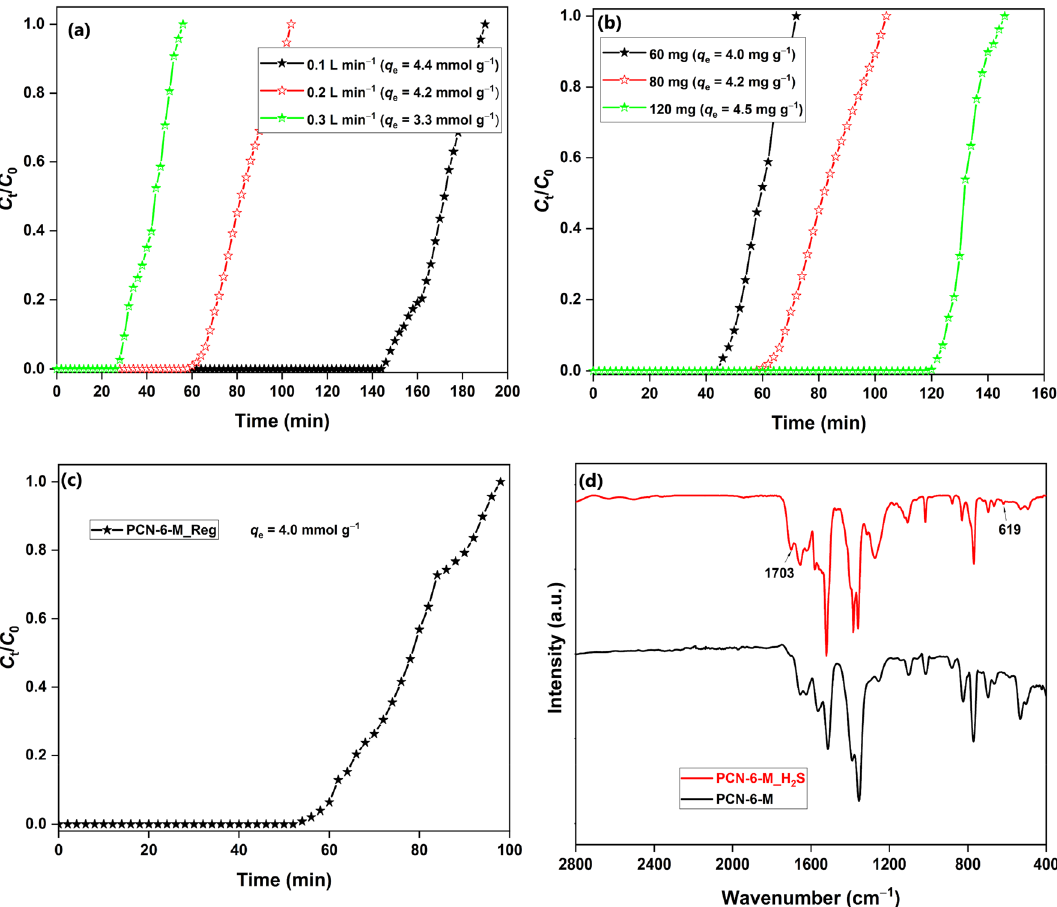
Figure 4. Effect of ( a ) flowrate; ( b ) MOF mass on H 2 S adsorption capacity of PCN-6-M; ( c ) H 2 S breakthrough curve of regenerated PCN-6-M; ( d ) FTIR spectra of fresh and H 2 S-adsorbed PCN-6-M (conditions: 80 mg MOF, 0.2 L min –1 flow rate, changed